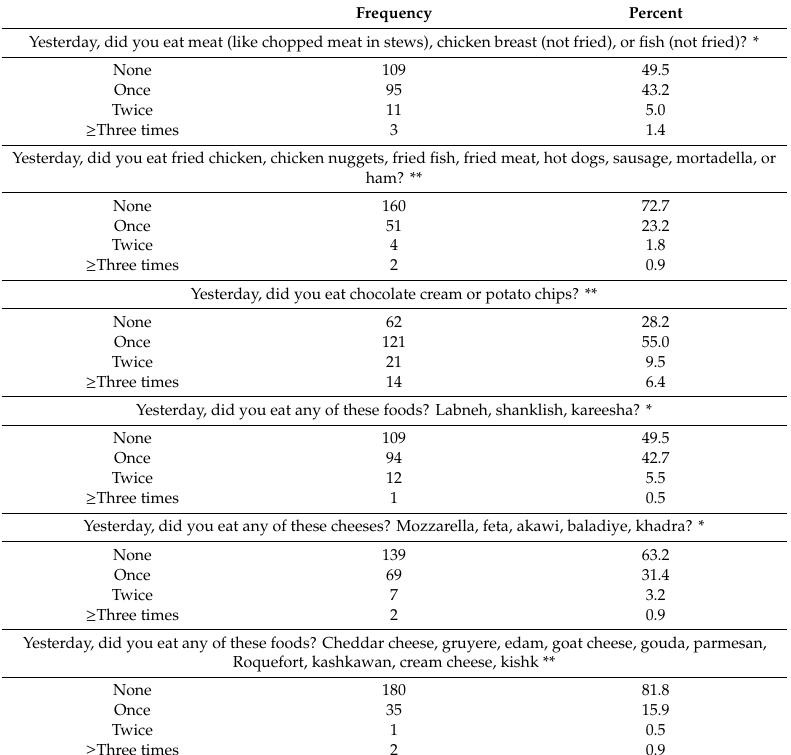
Table A6. Responses to the dietary adherence questionnaire by